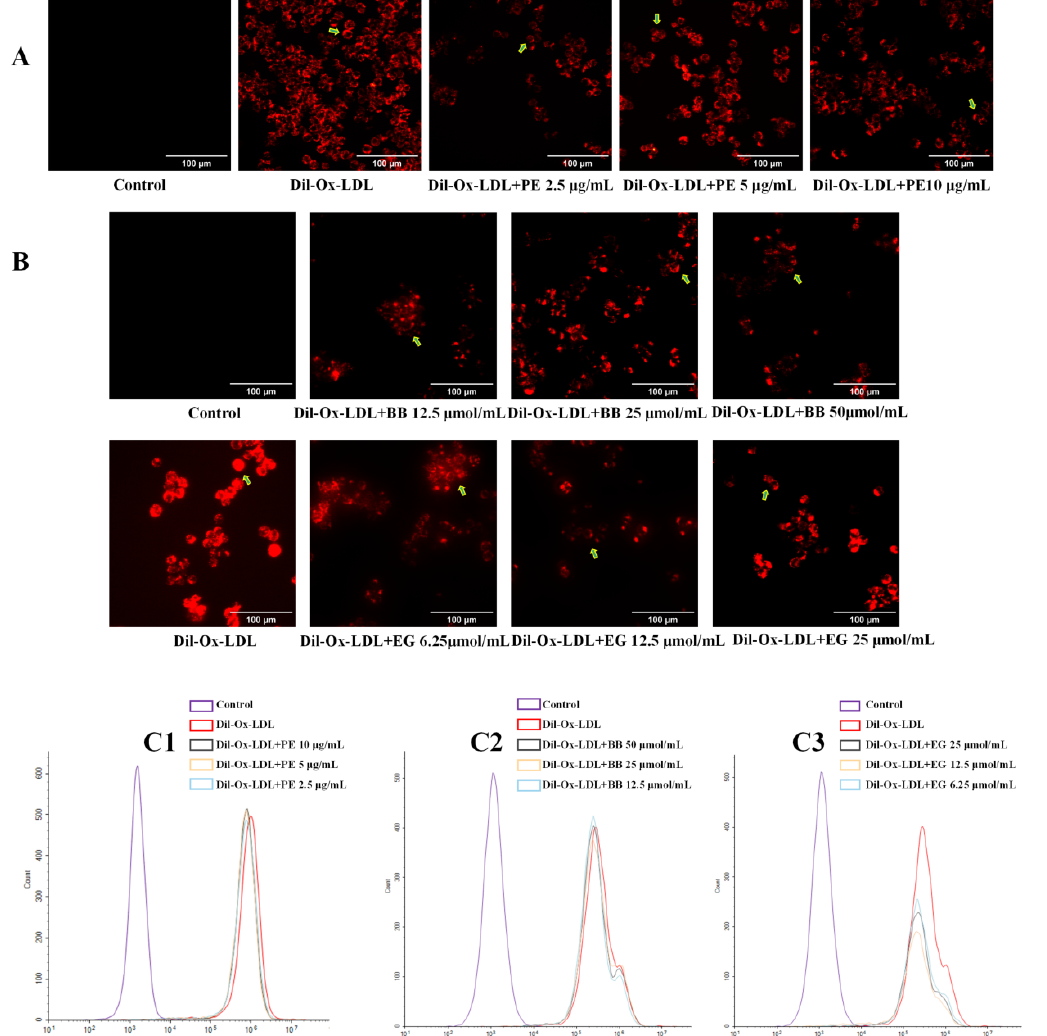
Figure 3. The effect of PE (10, 5, 2.5 μ g/mL) and its two components BB (50, 25, 12.5 μ mol/mL) and EG (25, 12.5, 6.25 μ mol/mL) on Dil-ox-LDL absorption. The fluorescence staining area and intensity of the cells were observed by inverted fluorescence microscopy (Figure 3 A, B, the Dil-ox-LDL loaded cells were pointed out by green arrows); the contents of intracellular Dil-ox-DL were calculated by MFI with flow cytometry analysis ( C1 – C3 ). All data were run at least three times.